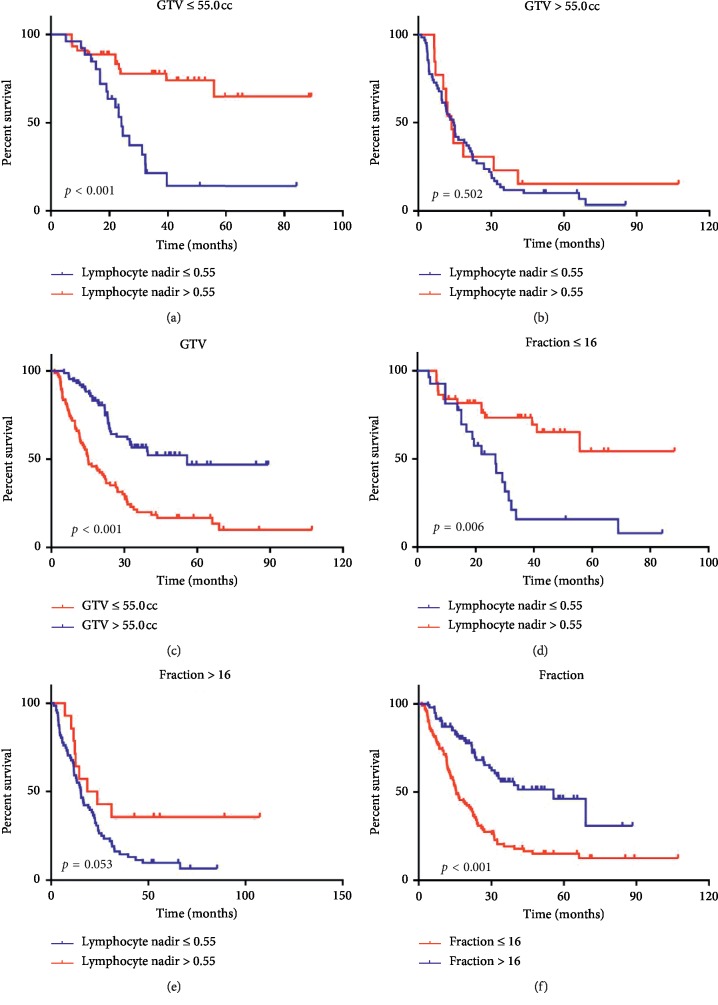
Survival curves according to independent prognostic factors. (a) Survival curves of patients in high and low lymphocyte nadir groups stratified by GTV ≤55.0 cc. The 1-year survival rate was 90.9% vs.77.7%; the 2-year survival rate was 88.5% vs. 53.0%; p < 0.001. (b) Stratified by GTV >55.0 cc (14.6 vs. 13.7; p=0.502). (c) Survival curve according to GTV groups (55.8 vs. 15.0 months; p < 0.001). (d) Survival curves of patients in high and low lymphocyte nadir groups stratified by fraction number ≤16. 1-year survival rate was 84.1% vs. 81.5%; 2-year survival rate was 73.4% vs. 52.3%; p=0.001. (e) Stratified by fraction number >16 (15.3 vs. 21.1 months; p=0.053). (f) Survival curve according to fraction number (55.8 vs. 15.4 months; p < 0.001).